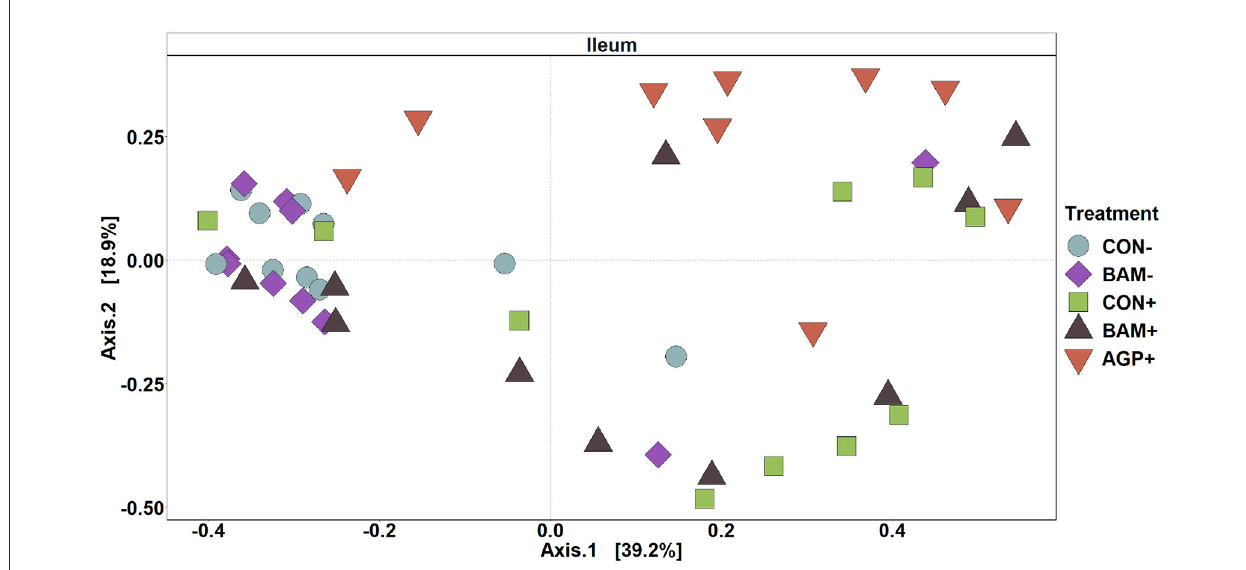
FIGURE7 Principal coordinate analysis (PCoA) based on Bray-Curtis distance for beta diversity of ileal digesta of weaned pigs fed with a control (CON) diet or diets supplemented with Bacillus amyliloquefaciens (BAM) and antibiotics (AGP). Different symbols and shapes represent treatments. Each treatment has 9–10 observations.